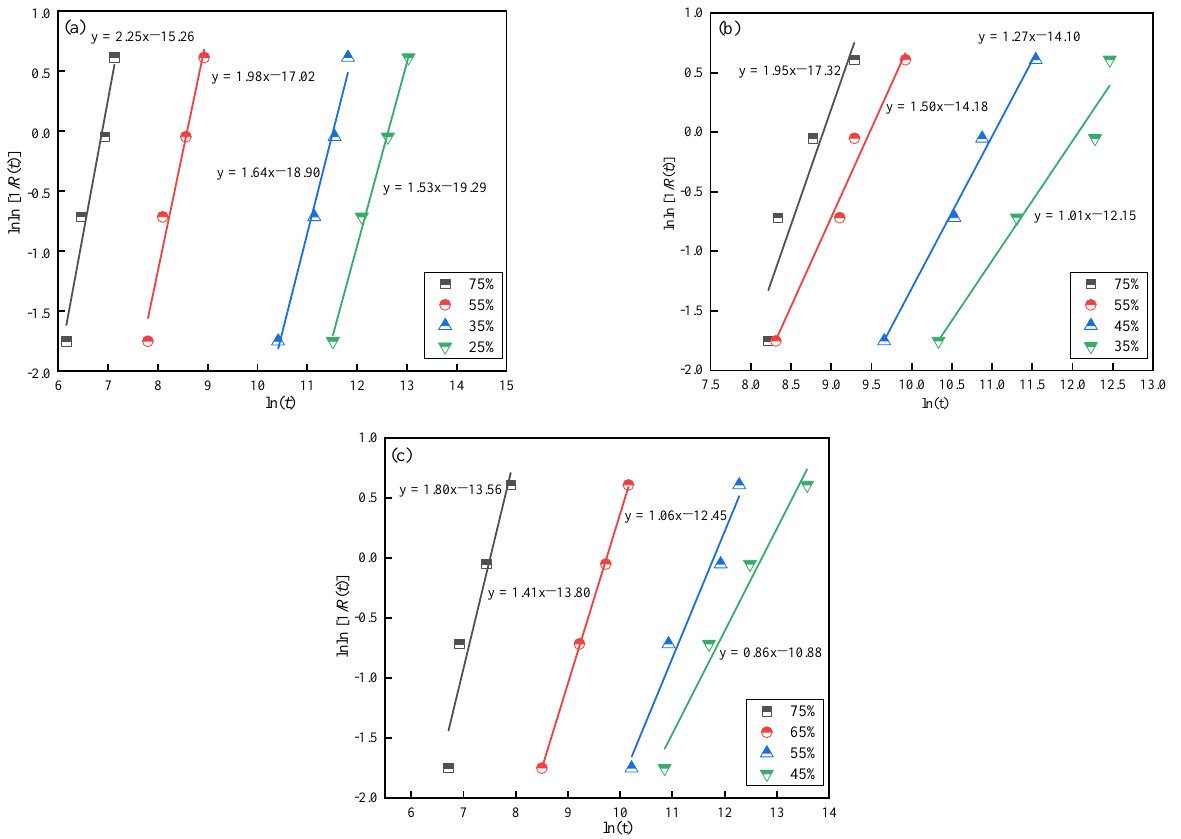
Figure 5. Weibull probability plot under different load levels: ( a ) [0/90] 4s , ( b ) [0/45/ − 45/90] 2s , and ( c ) [45/ − 45] 4s .